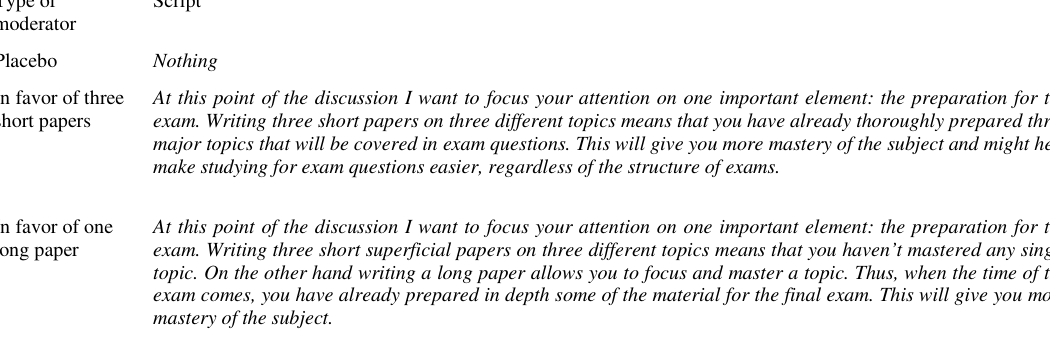
Table A3: First discussion, midway intervention